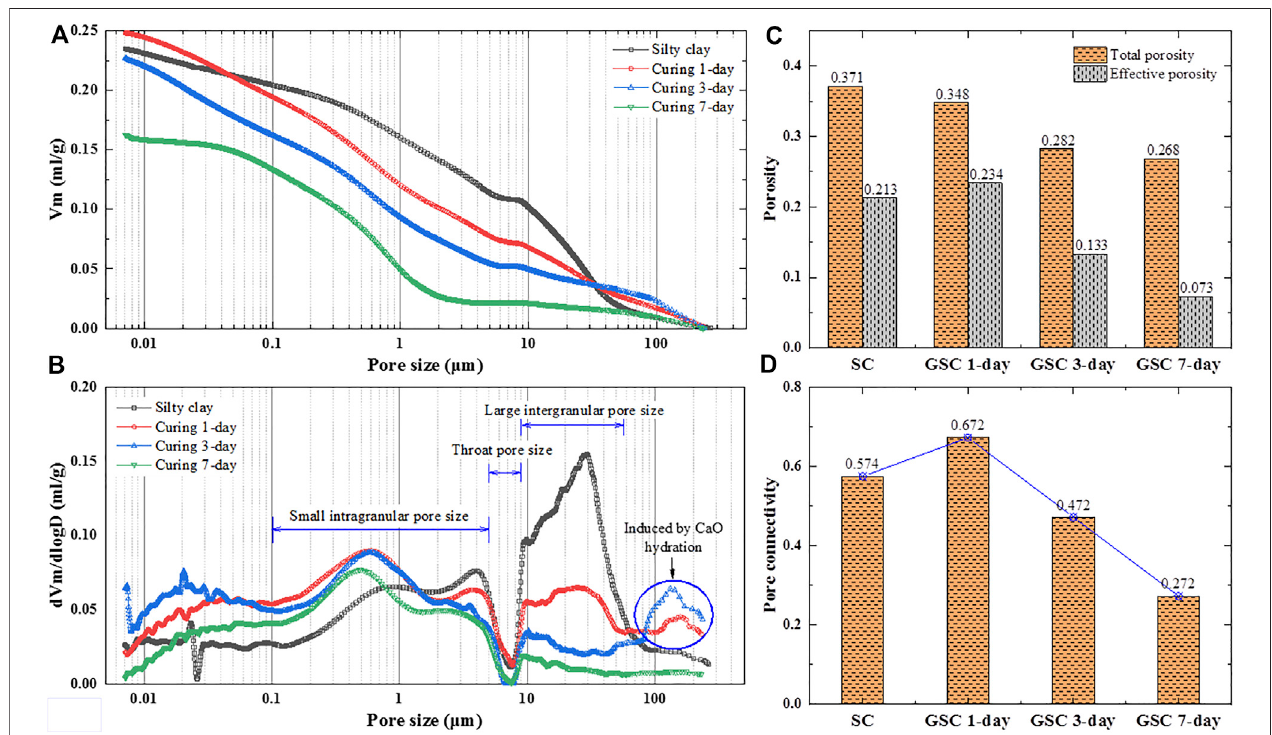
FIGURE 4 | Pore structure characteristics of SC and GSC after curing for 1 day, 3 days, and 7 days.